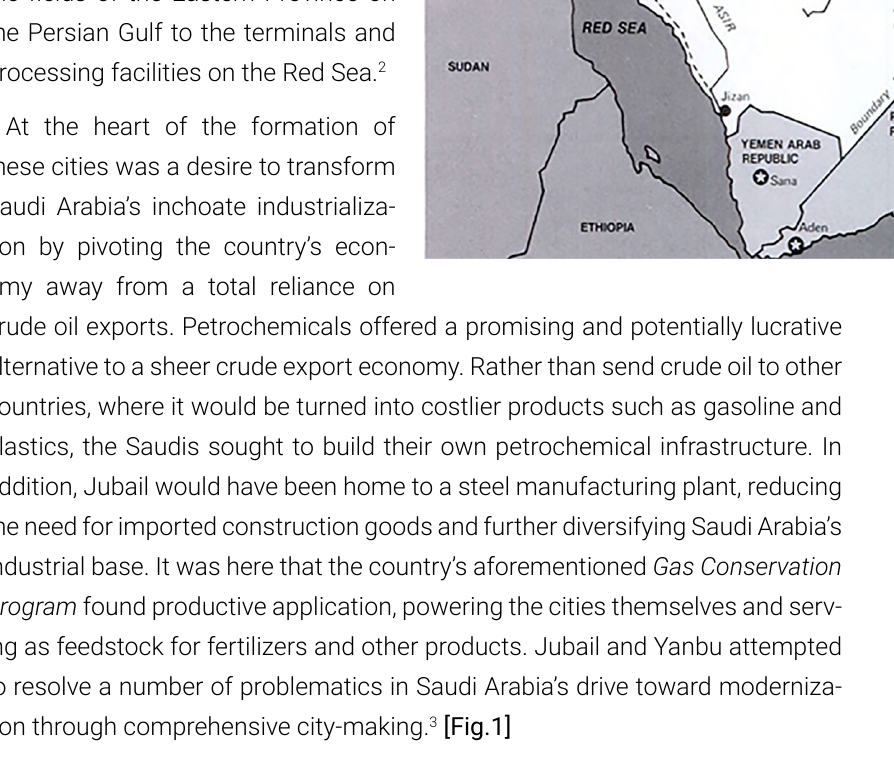
Fig. 1 Map of Saudi Arabia showing Jubail on the Persian Gulf and Yenbo [sic] on the Red Sea. Connecting the two cities would be a gas pipeline. Source: “Housing and urban de- velopment in Saudi Arabia,” U.S. Department of Hous-ing and Urban Development (Washing- ton: U.S. GPO, 1977),